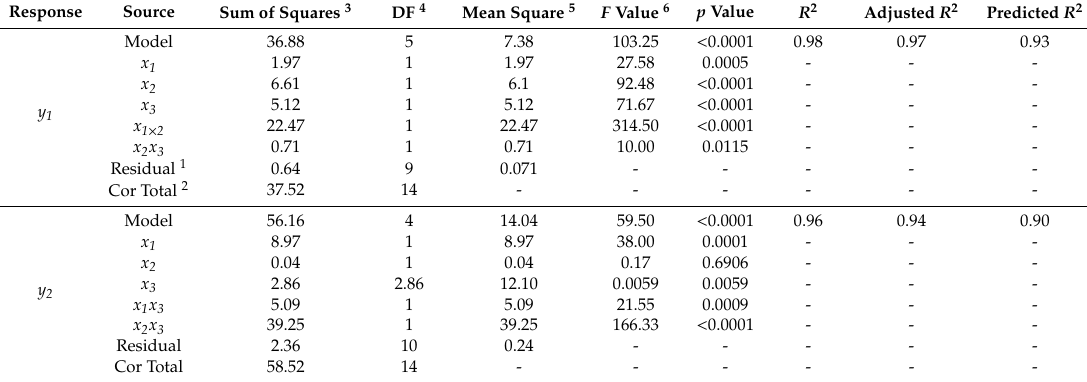
1 Residual: Di ff erence between observed value and predicted value. 2 Cor Total: The amount of variation around the mean of the observation. 3 Sum of squares: The sum of the squared di ff erences between the overall average and the amount of variation. 4 DF (Degree of Freedom): The estimated number of parameters used to calculate the sum of squares of the source. 5 Mean square: The sum of squares divided by DF. 6 F value: Test that compares the mean square of source and the mean square of